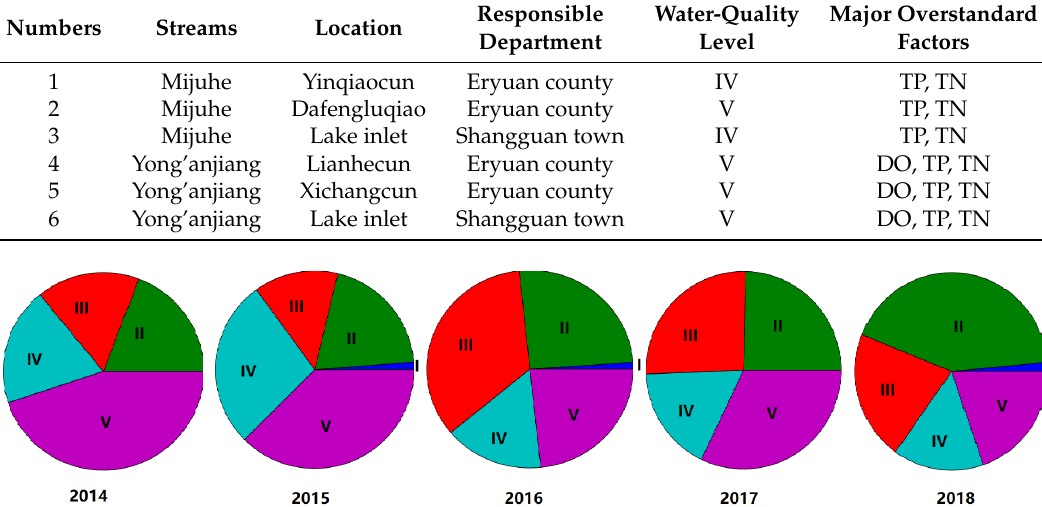
Figure 2. Yearly distribution of water-quality levels using fan diagram on 10 monitoring stations in Erhai Lake.